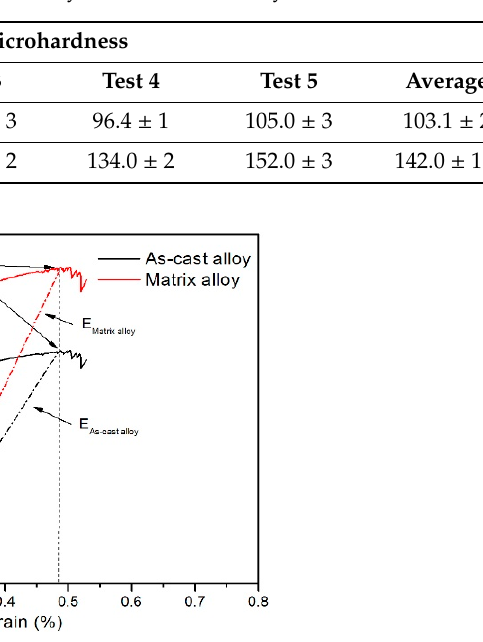
Table 3. Microhardness of the as-cast alloy and the matrix alloy.